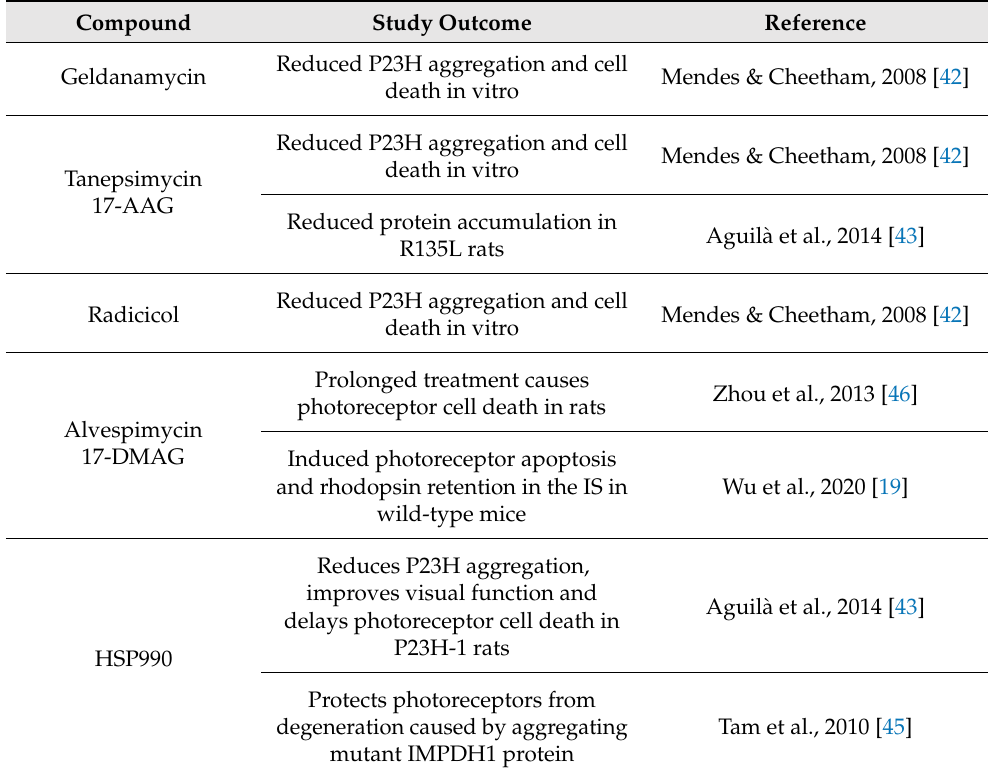
Table 1. List of Hsp90 inhibitors used in models of retinal